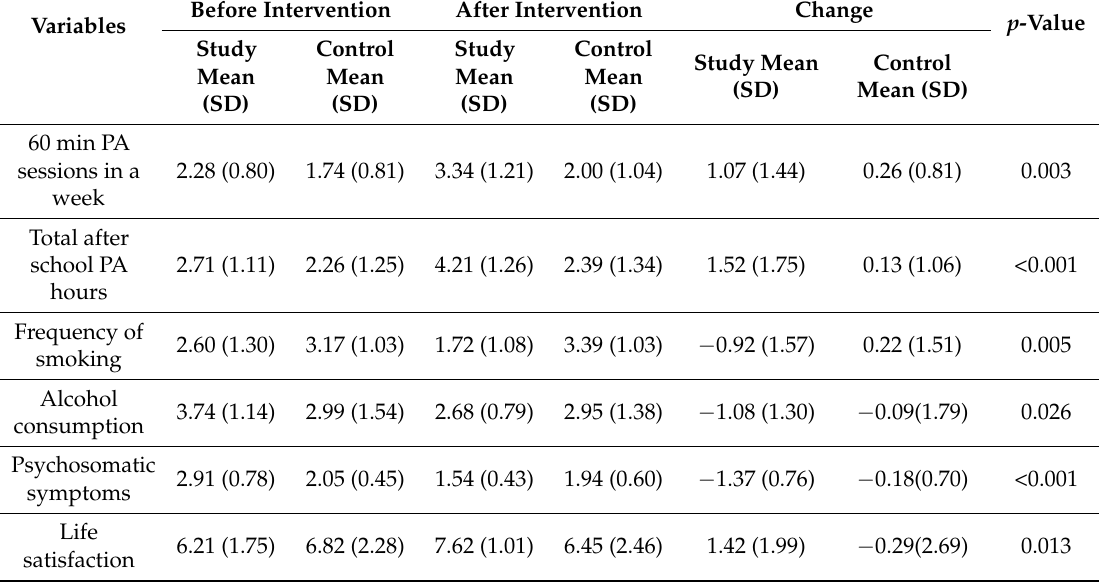
Table 2. Differences between groups in the changes before and after